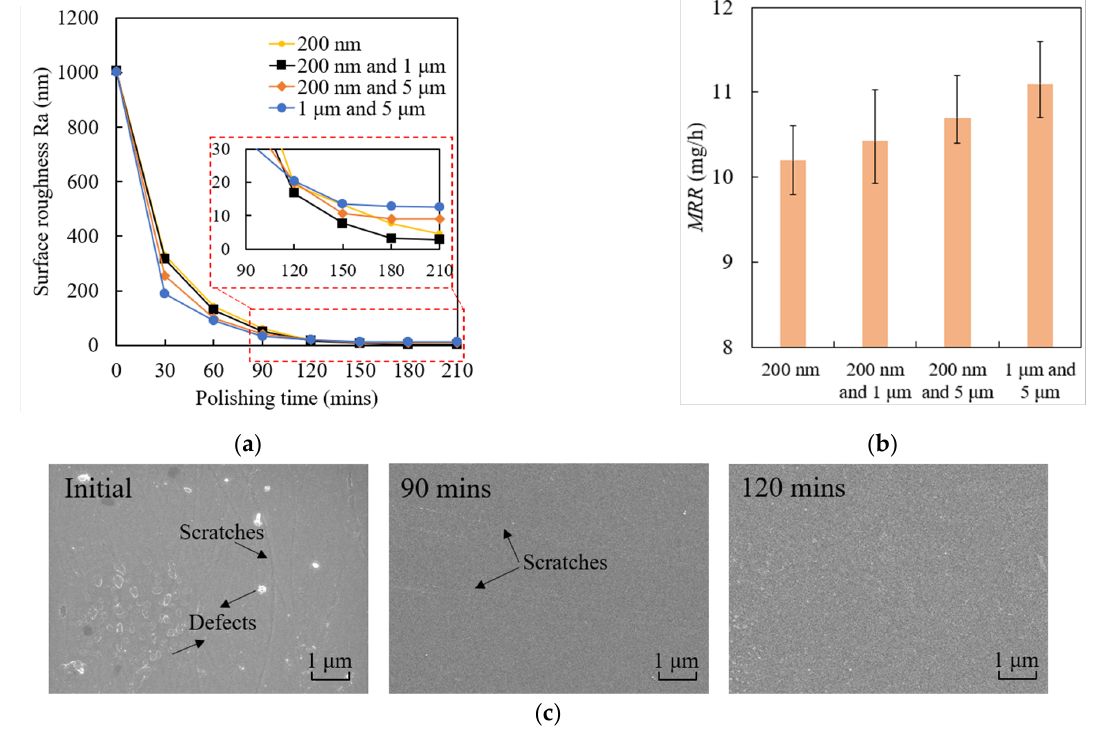
Figure 13. Polishing performance with mixture abrasive particles: ( a ) surface roughness R a , ( b ) material removal rate MRR , ( c ) improvement on surface morphology.